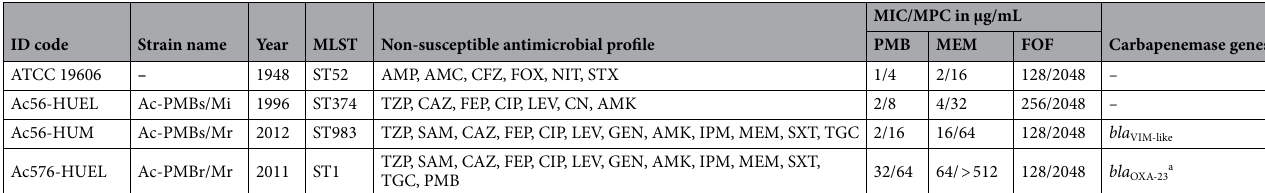
Table 1. Antimicrobial susceptibility profile and molecular characteristics of selected A. baumannii strains. Susceptibility antimicrobial profile results were performed by automated systems. CLSI 2019 A. baumannii breakpoints (µg/mL) for PMB: susceptible (S) ≤ 2 and resistant (R) ≥ 4; and MEM: S ≤ 2, intermediate 4, R ≥ 8. EUCAST 2020 A. baumannii breakpoints (µg/mL) for colistin: S ≤ 2 and R > 2; and MEM: S ≤ 2 and R ≥ 8. FOF breakpoints (µg/mL) for Enterobacteriales according to the CLSI 2019 guidelines: S ≤ 64, intermediate 128, R ≥ 256. MLST multilocus sequence typing, ST sequence type, AMP ampicillin, AMC